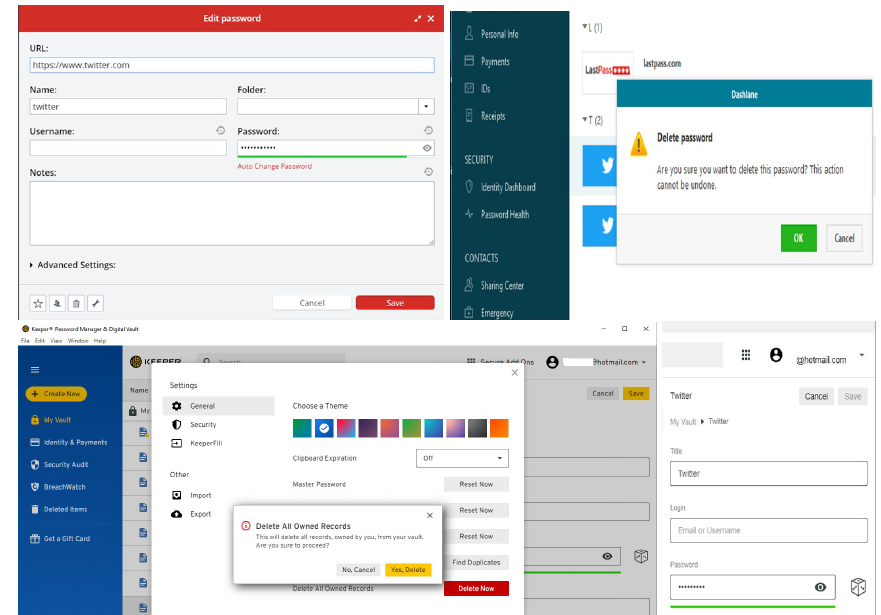
Figure A1. Remove username from LastPass. Remove password from Dashlane and save the changes without the undo function. There is no undo for deleting all records and username in Keeper (personal email is hidden).